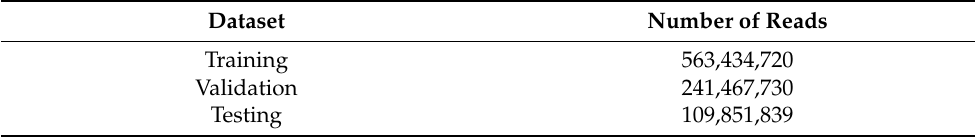
Table 2. The total number of simulated reads in training, validation and testing datasets.